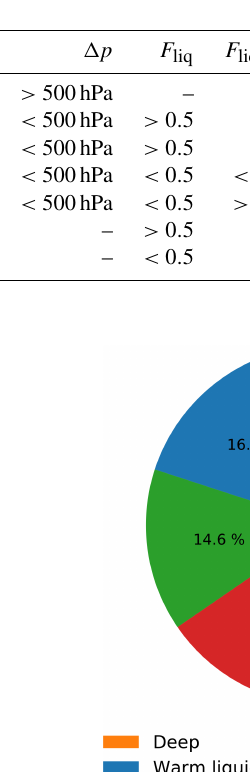
Table 4. Definition of cloud types. We categorize and separate clouds by exceeding thresholds of the five predictors: the heterogeneous freezing origin fraction F het , cloud top to bottom pressure difference (cid:49)p , cloud liquid fraction F liq , liquid origin fraction F liq − o and the cloud top temperature T top . If a predictor is not used for a certain class, it is symbolized by a “–” sign.